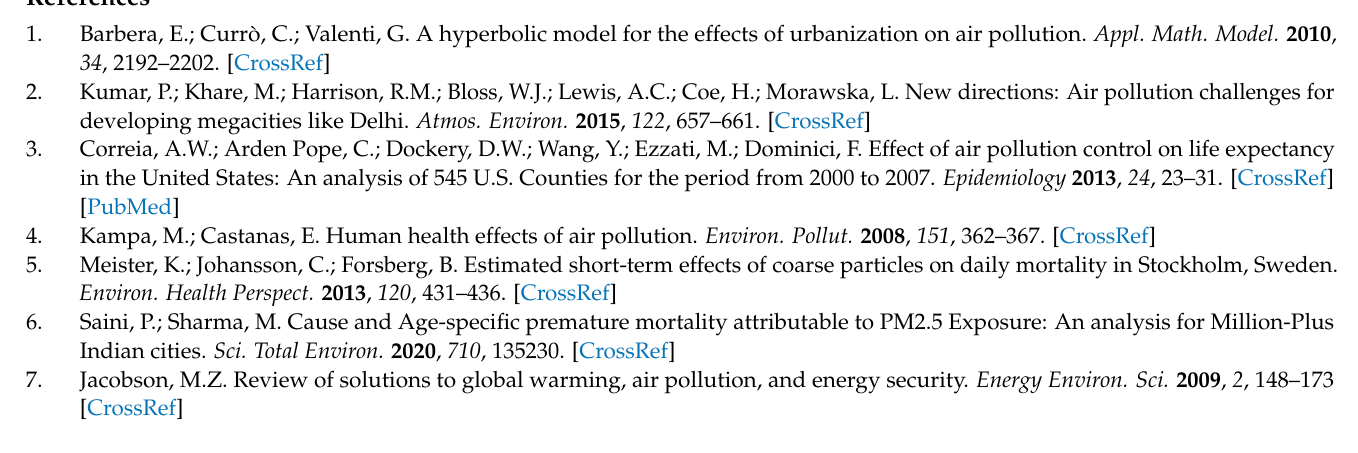
from a minimal set. Table S1: Evaluation metrics for sensor vs reference instrument comparison. Table S2: Metric to test reproducibility and repeatability of LCS for AQM. Algorithm S1: Procedure to select